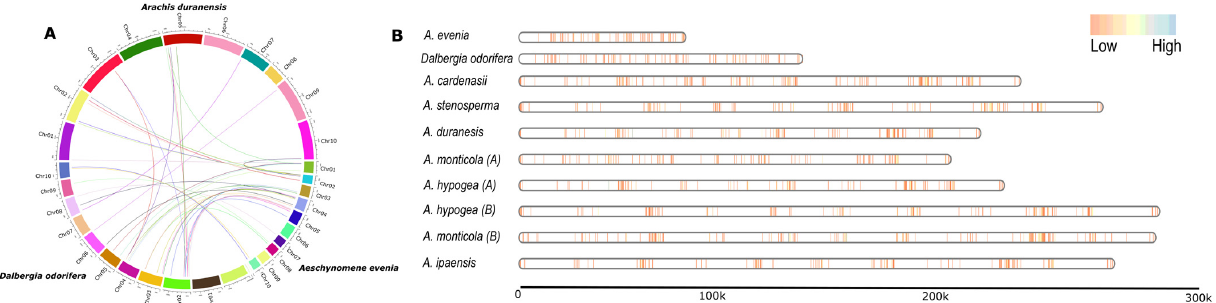
Figure 2. Landscape of NLR genes using synteny and gene density analysis. ( A ) Synteny analysis of NLR genes from three species A. duranensis , A. evenia, and D. odorifera. ( B ) The NLRs genes are located on chromosomes denoted in vertical blue and red lines, inferring the gene density map between genome assemblies of Arachis, Dalbergia, and A. evenia species. These plot show placement of genes on linearized chromosomes that are joined together using a bin size of 5 kb.